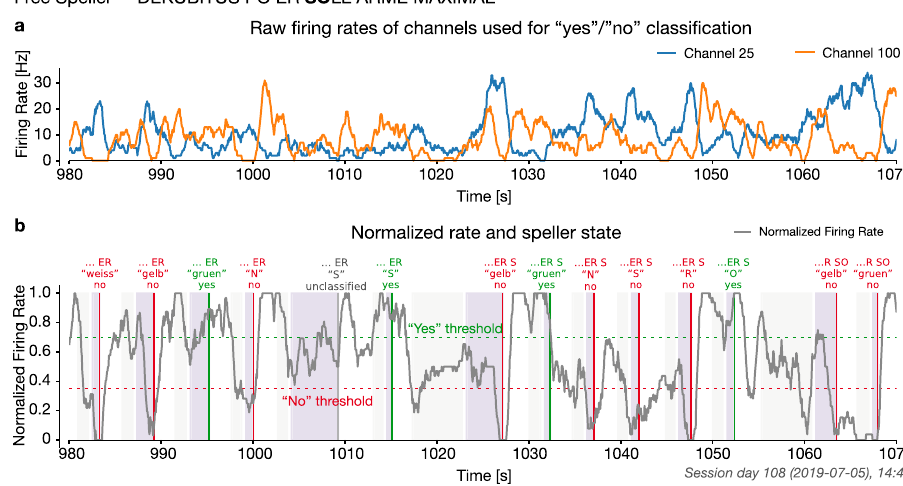
Fig. 3 Example of letter selection during a free spelling block. a Firing rate of the channels 25 and 100 used for “ yes ” / “ no ” classi fi cation on day 108. b Normalized fi ring rate and the speller state during the same 90 s period of a speller block. “ Yes ” / “ no ” / timeout decisions are marked by vertical lines and the option selected in green and not selected in red. This example is part of the phrase “ dekubitus po er soll arme maximal ” , referring to bedsore and instructing the aide to change arm position. Source data are provided as a Source Data fi le.